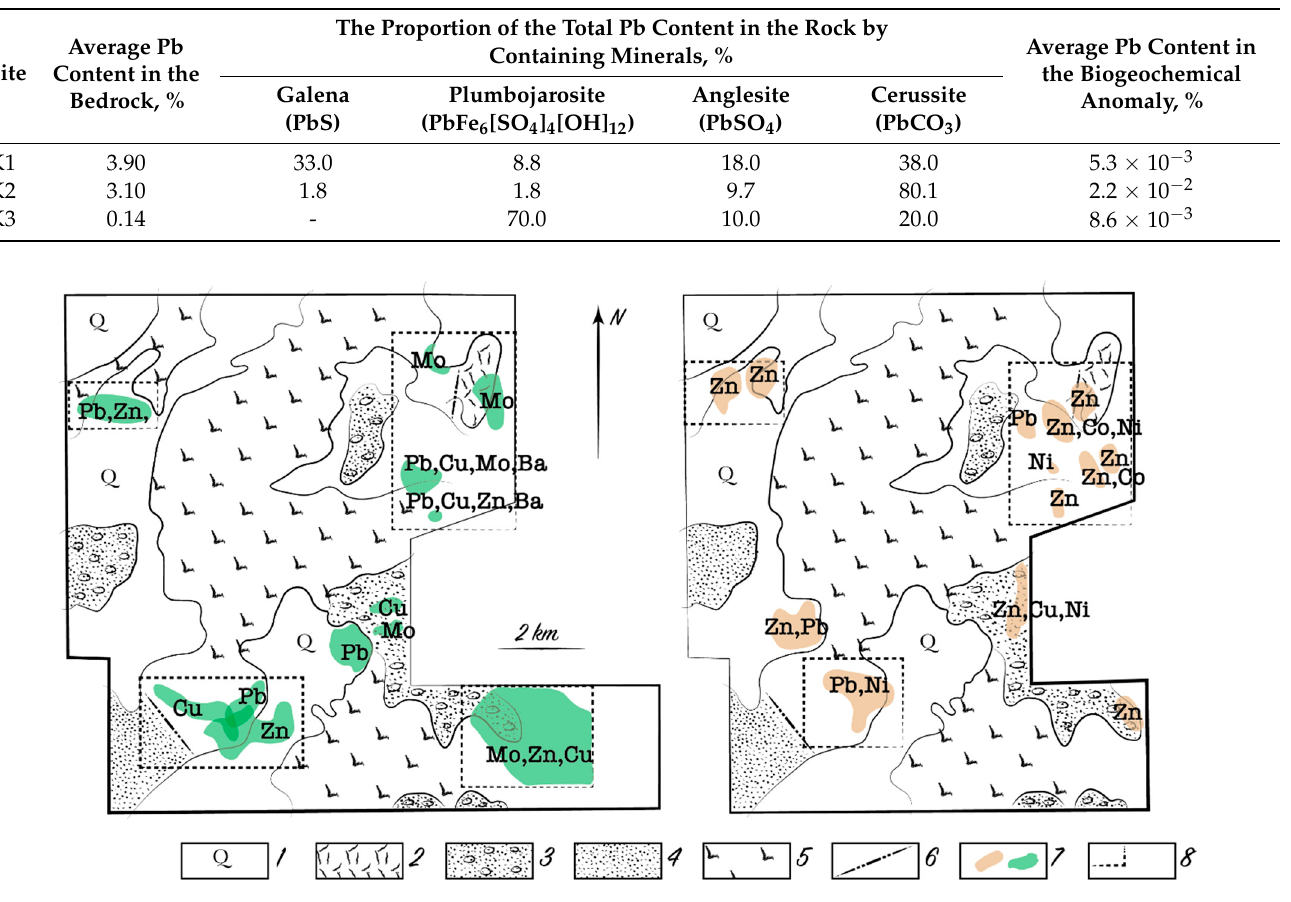
Table 4. Lead content in the ash of cherry ( Cerasus fruticosa Pall.) growing over polymetallic ore bodies with different mineral composition in the Karatau Mountains.